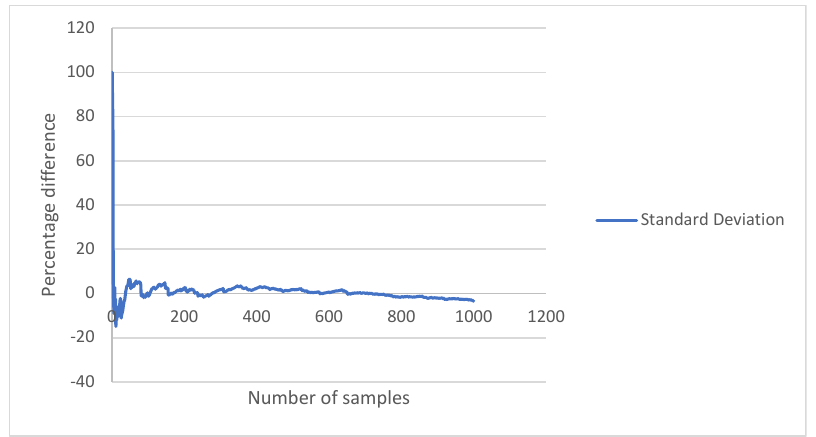
Figure 6. Convergence of the standard deviation of a randomly selected Monte Carlo simulation for the output failure load. In the horizontal axis, the number of samples; and in the vertical axis, the percentage difference of the standard deviation in relation to the statistical moment in the 100